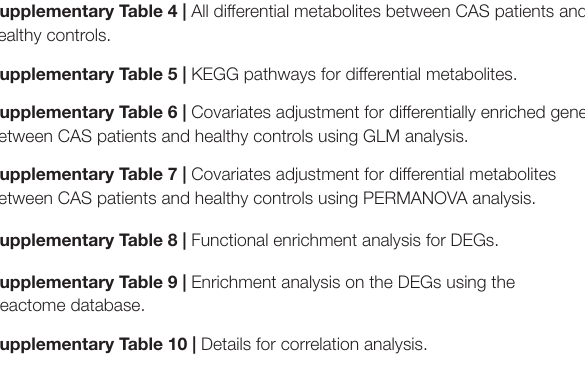
Supplementary Table 1 | The α -diversity for CAS and healthy controls. Supplementary Table 2 | Differentially enriched microbiota from all levels. Supplementary Table 3 | Differential KEGG pathways predicted by PICRUSt. Supplementary Table 4 | All differential metabolites between CAS patients and healthy controls. Supplementary Table 5 | KEGG pathways for differential metabolites.